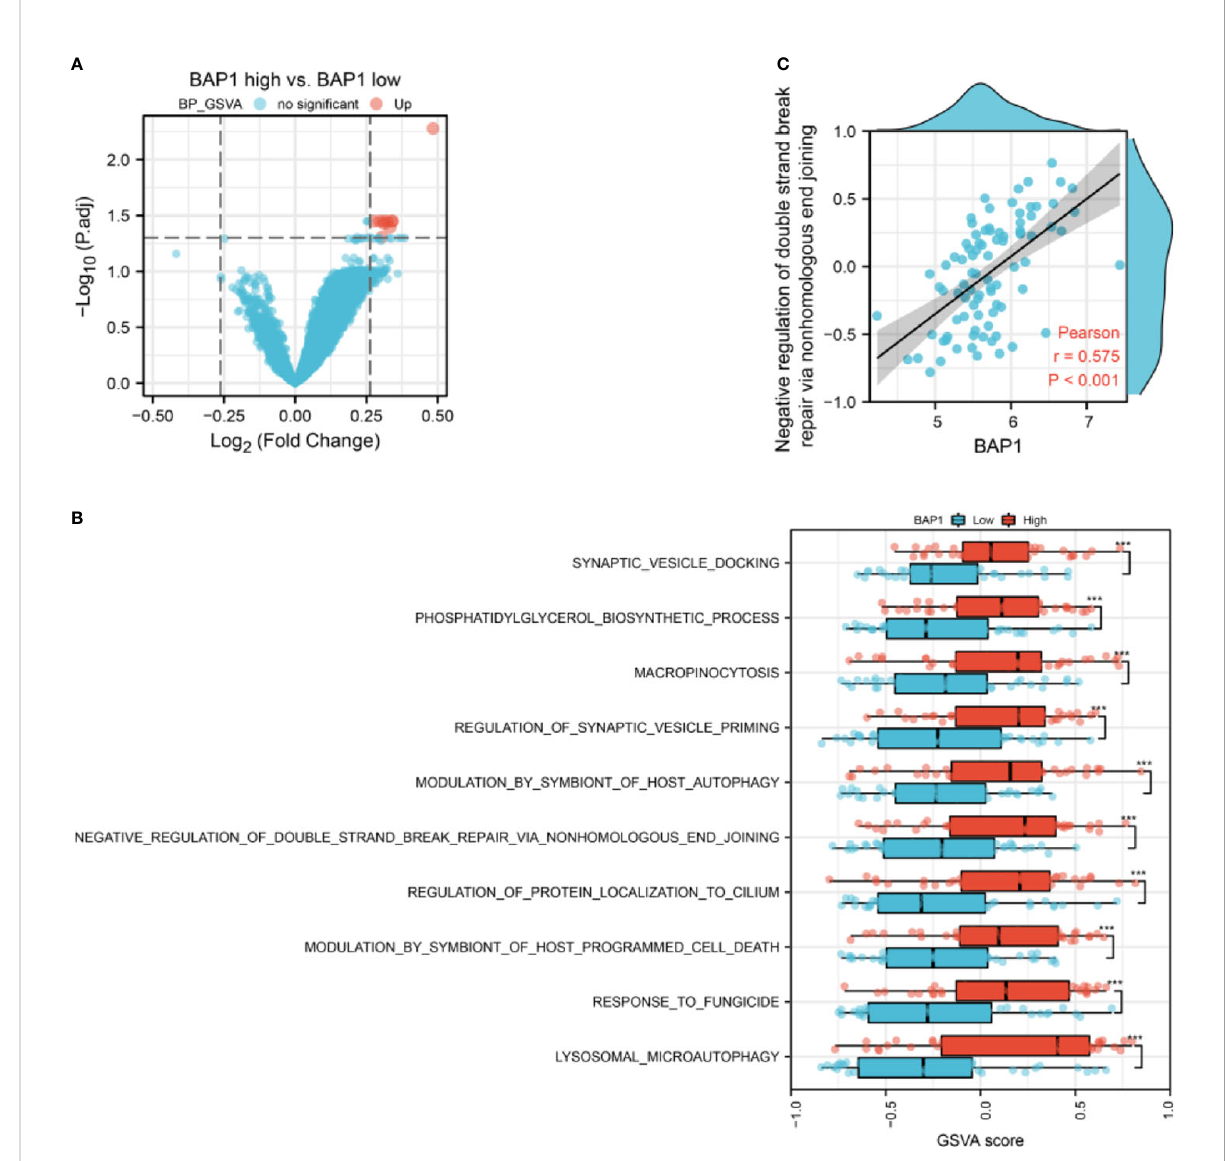
FIGURE 8 The correlation of BAP1 and GSVA score of GO-BP gene sets. (A) The difference of GSVA score of GO-BP gene sets in low and high BAP1 groups. (B) The GO-BP gene sets with differential GSVA score. (C) The correlation of BAP1 and negative regulation of double strand break repair via nonhomologous end